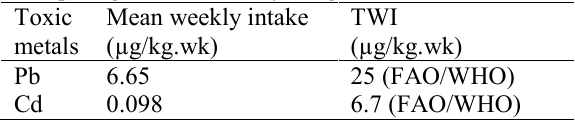
Table 3. Mean weekly intake of Pb and Cd from breast